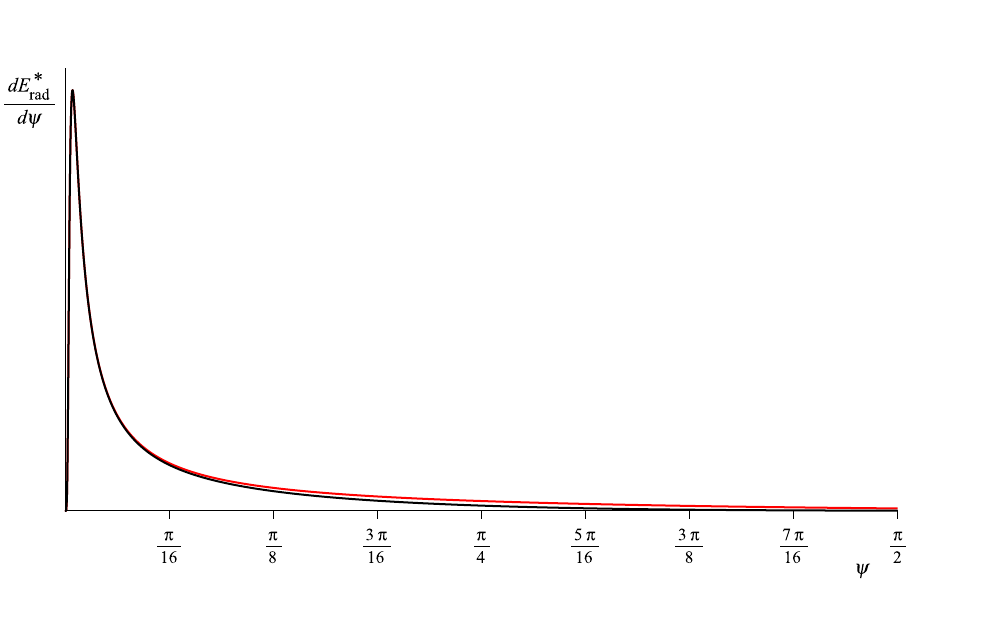
Figure 6 . The reduced angular distribution of the emitted radiation (red) versus the approximation by formula (5.14) (black) for D = 6 ; (cid:13) = 150. For higher values of (cid:13) two curves are more close to each other.